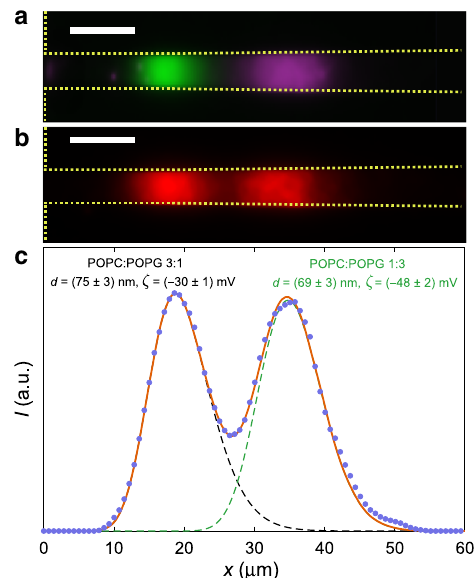
Fig. 4 Separating a mixture of liposomes. a Fluorescence image of trapped POPC:POPG 3:1 and POPC:POPG 1:3 liposomes marked with different fl uorophores in a nanochannel (outlined with yellow). Experiment is performed at ln( C N / C W ) = − 8.1. Scale bar is 10 μ m. b Same as a , but for liposomes with identical fl uorophores. The image is an average over 10 s. Scale bar is 10 μ m. c Fluorescence intensity of the two trapped populations shown in b (blue dots) and corresponding fi t (red line) of the full distribution describing two particle populations, C p ( x ) = w 1 C p,1 ( x ) + w C x ). Here C C fi ts to Eq. (7) for the two particle 2 p,2 ( p,1 and p,2 are the populations, and w 1 and w 2 are weight factors with w 1 + w 2 =